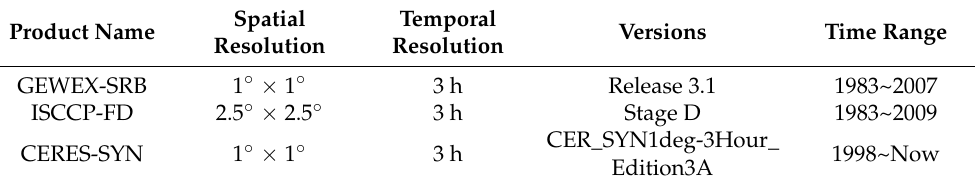
Table 1. Key information of DLR products evaluated in the